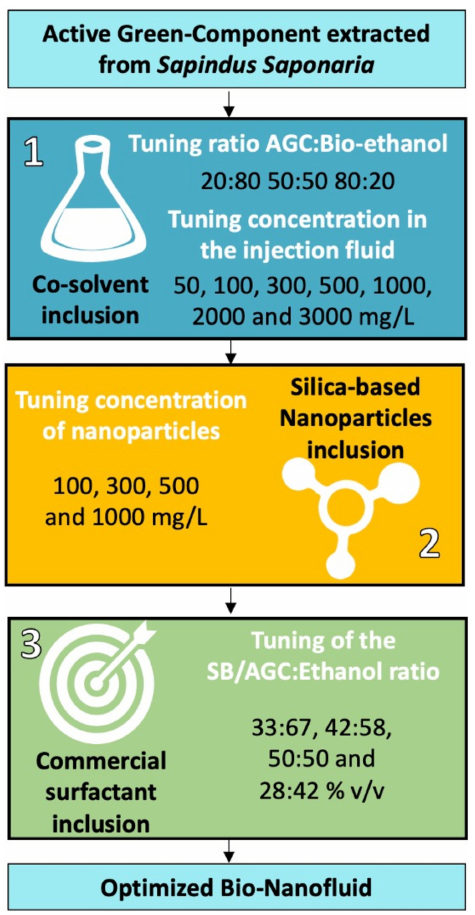
Figure 1. Roadmap for the tuning of the